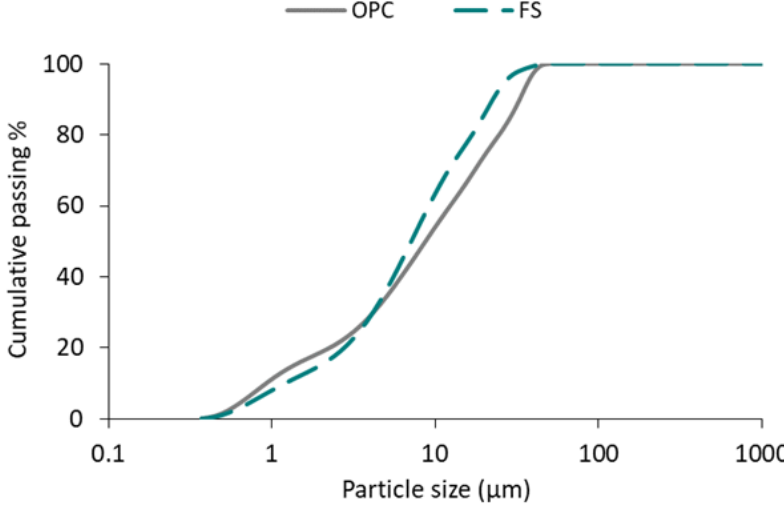
Figure 1. Particle size distribution of cement and flash-calcined sediment.